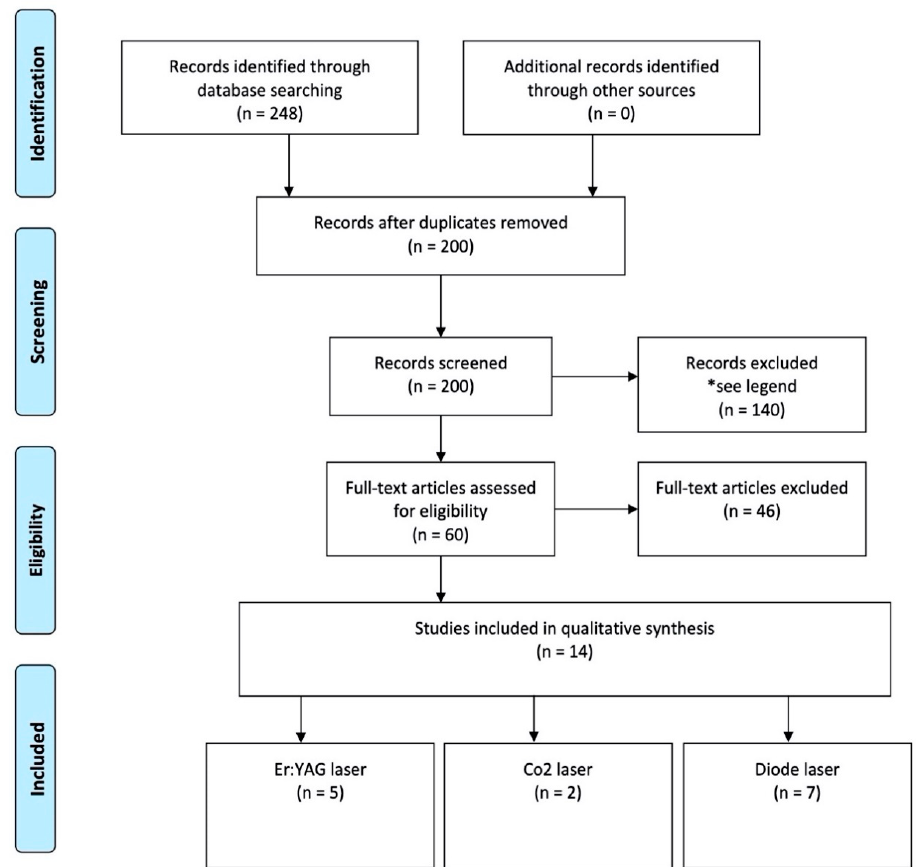
Figure 1. Flowchart depicting the article selection process. * Exclusion criteria: studies assessing the effectiveness of laser treatment by using only radiographs and evaluating the effectiveness of lasers in peri-implantitis treatment in vitro only.